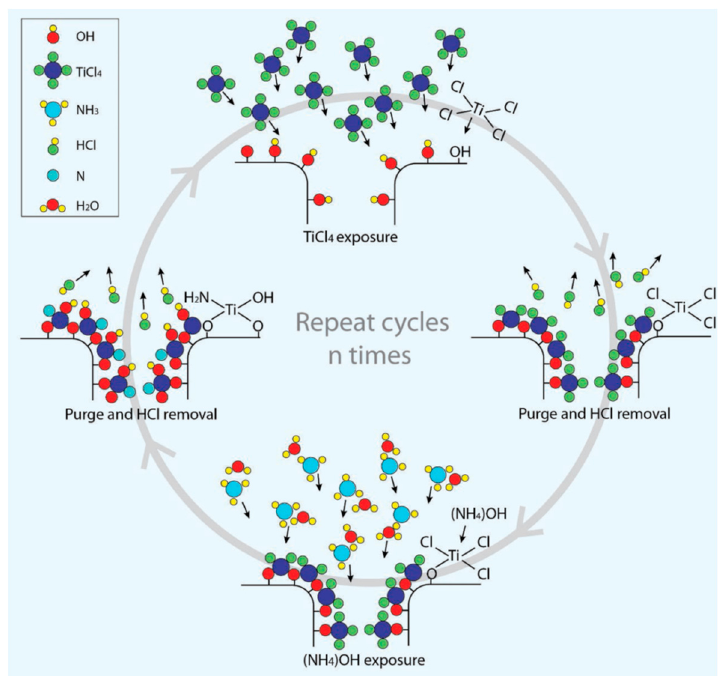
Figure 7. Schematic illustration demonstrating the synthesis process of the N-doped TiO 2 conformal film via the ALD method. Adapted with permission from Reference [56]. Copyright (2017) Wiley.